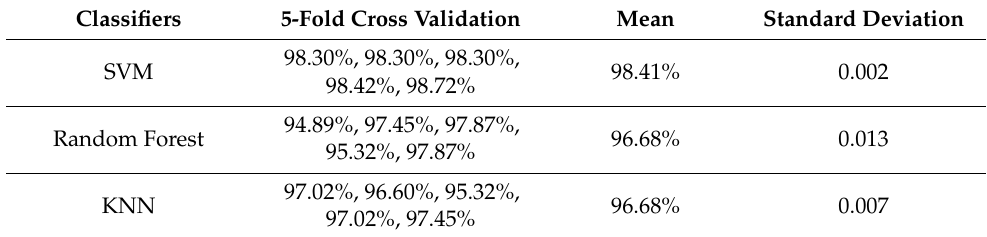
Table 4. The recognition performance of merged four activities.